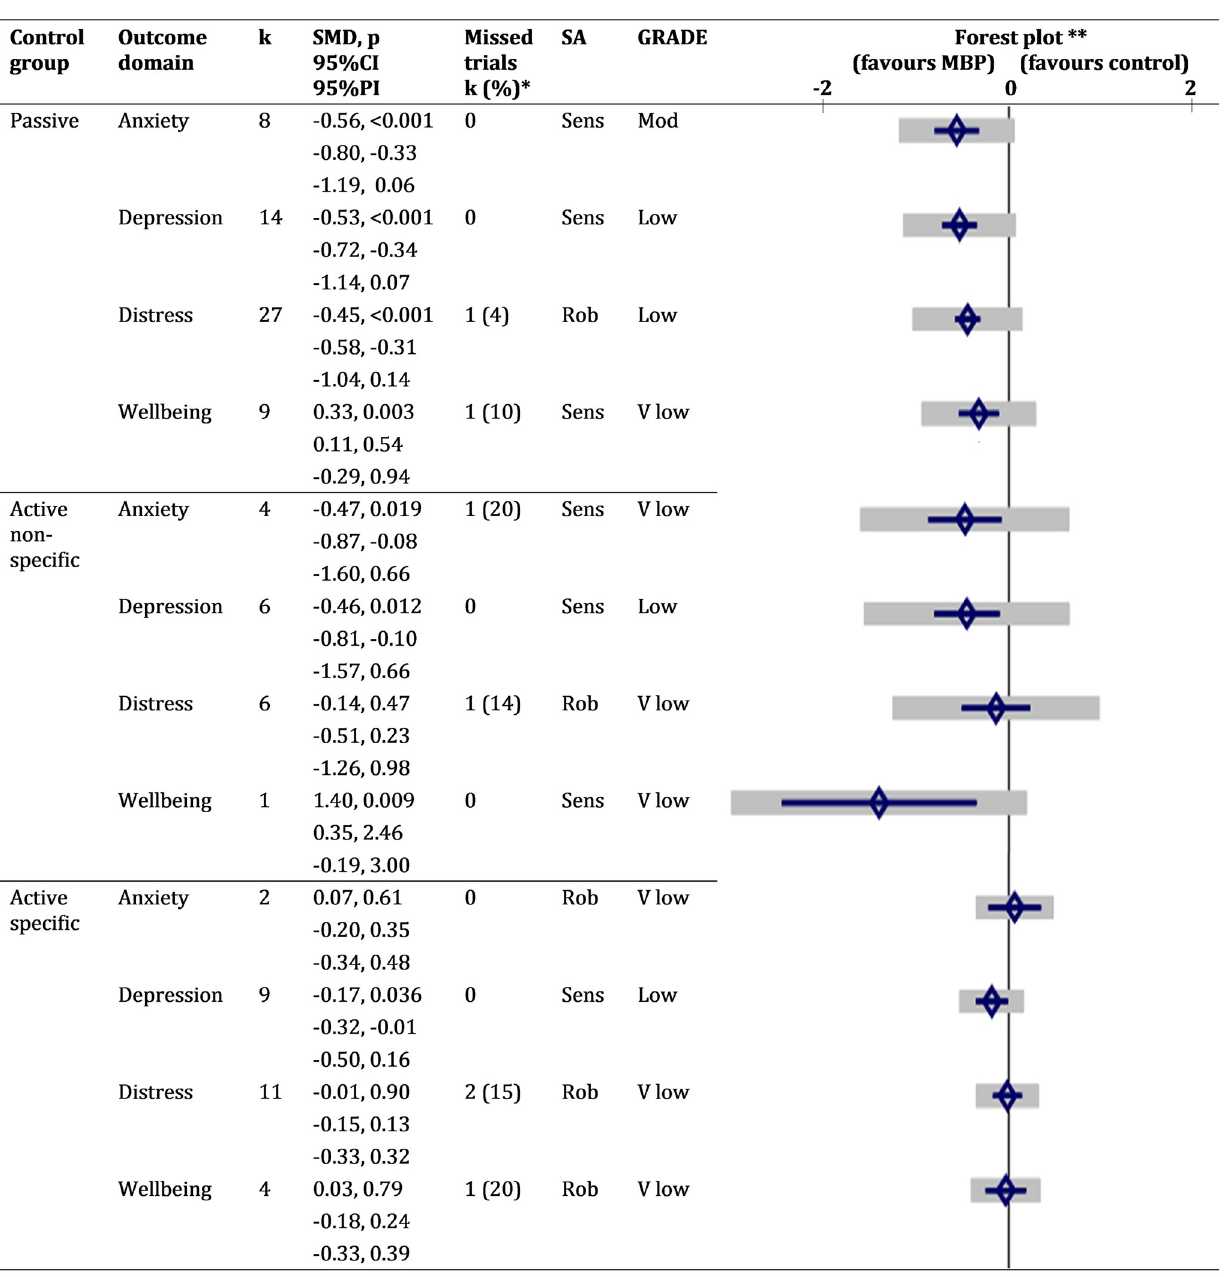
Fig 2. Summary of primary outcome results (outcome time point is 1–6 months post–intervention follow–up). � Number of trials with nonreported data for the corresponding outcome. �� Diamonds are SMDs, blue bars are 95%CIs, and grey bars are 95% PIs. CI, confidence interval for overall mean; GRADE, Grading of Recommendations Assessment, Development, and Evaluation approach to assess confidence in the cumulative evidence; k, number of trials; MBP, mindfulness–based programme; mod, moderate; PI, prediction interval for new study; Rob, robust; SA, sensitivity analysis; Sens, sensitive; SMD, standardised mean difference; v,